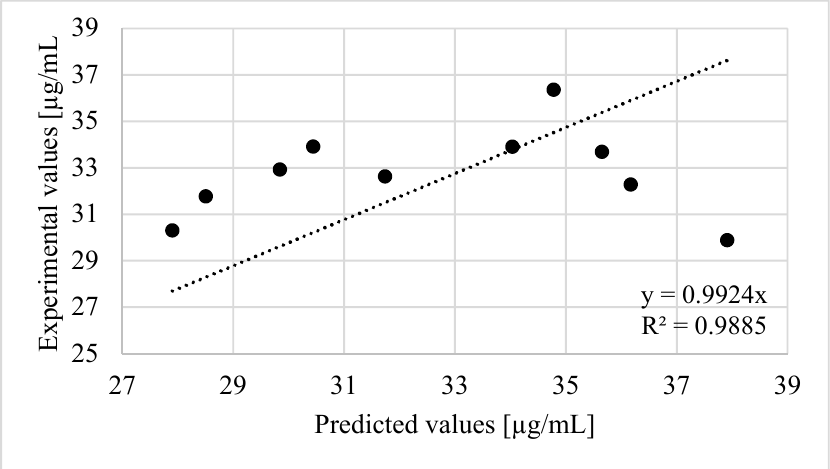
Figure 3. Validation of the model describing ammonia release built with RSM–regression analysis of experimental and predicted values.